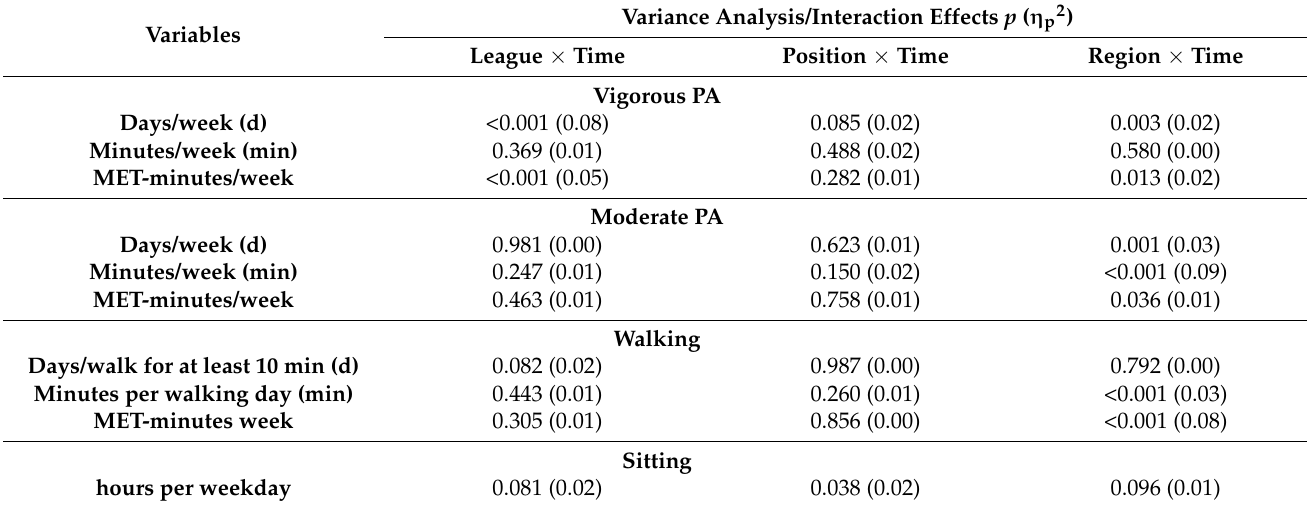
Table 5. Comparison of PA parameters depending on playing level (handball league), playing position, and region. Meaningful interaction effects (criteria: p < 0.05 and η p2 > 0.10) highlighted in bold.